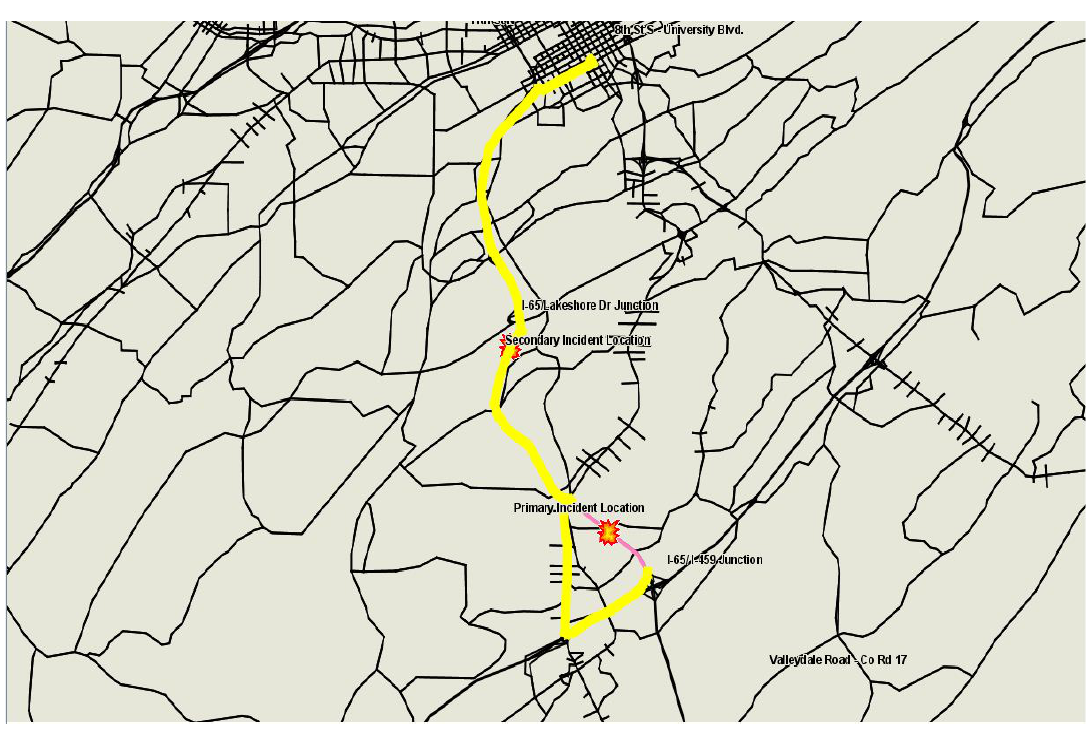
Figure 3. EMS vehicle’s path to UAB hospital in